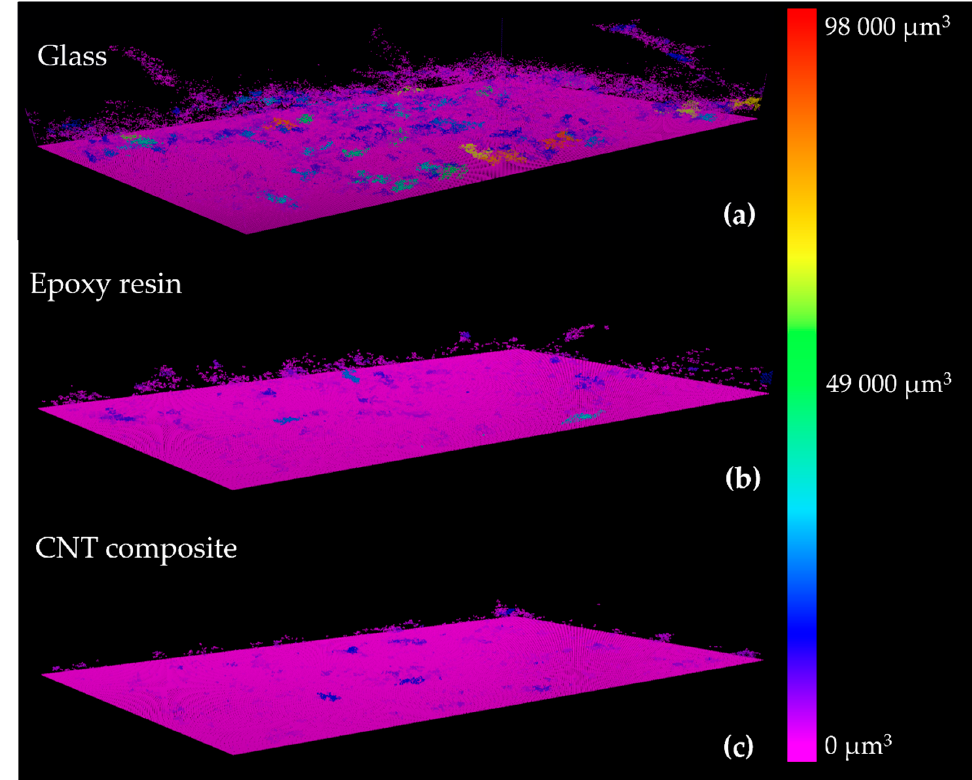
Figure 6. Representative 3D OCT images of the distribution of non-connected pores by size from Nodosilinea cf. nodulosa LEGE 10377 biofilms formed on glass ( a ), epoxy resin ( b ) and CNT composite ( c ) after 49 days. The color scale shows the range of the size of non-connected pores.